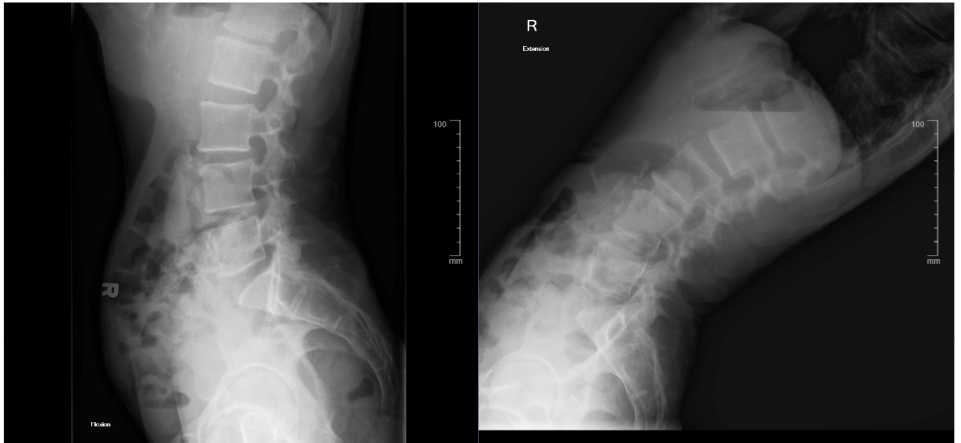
Figure 4. Flexion-extension X-ray showing no overt instability.